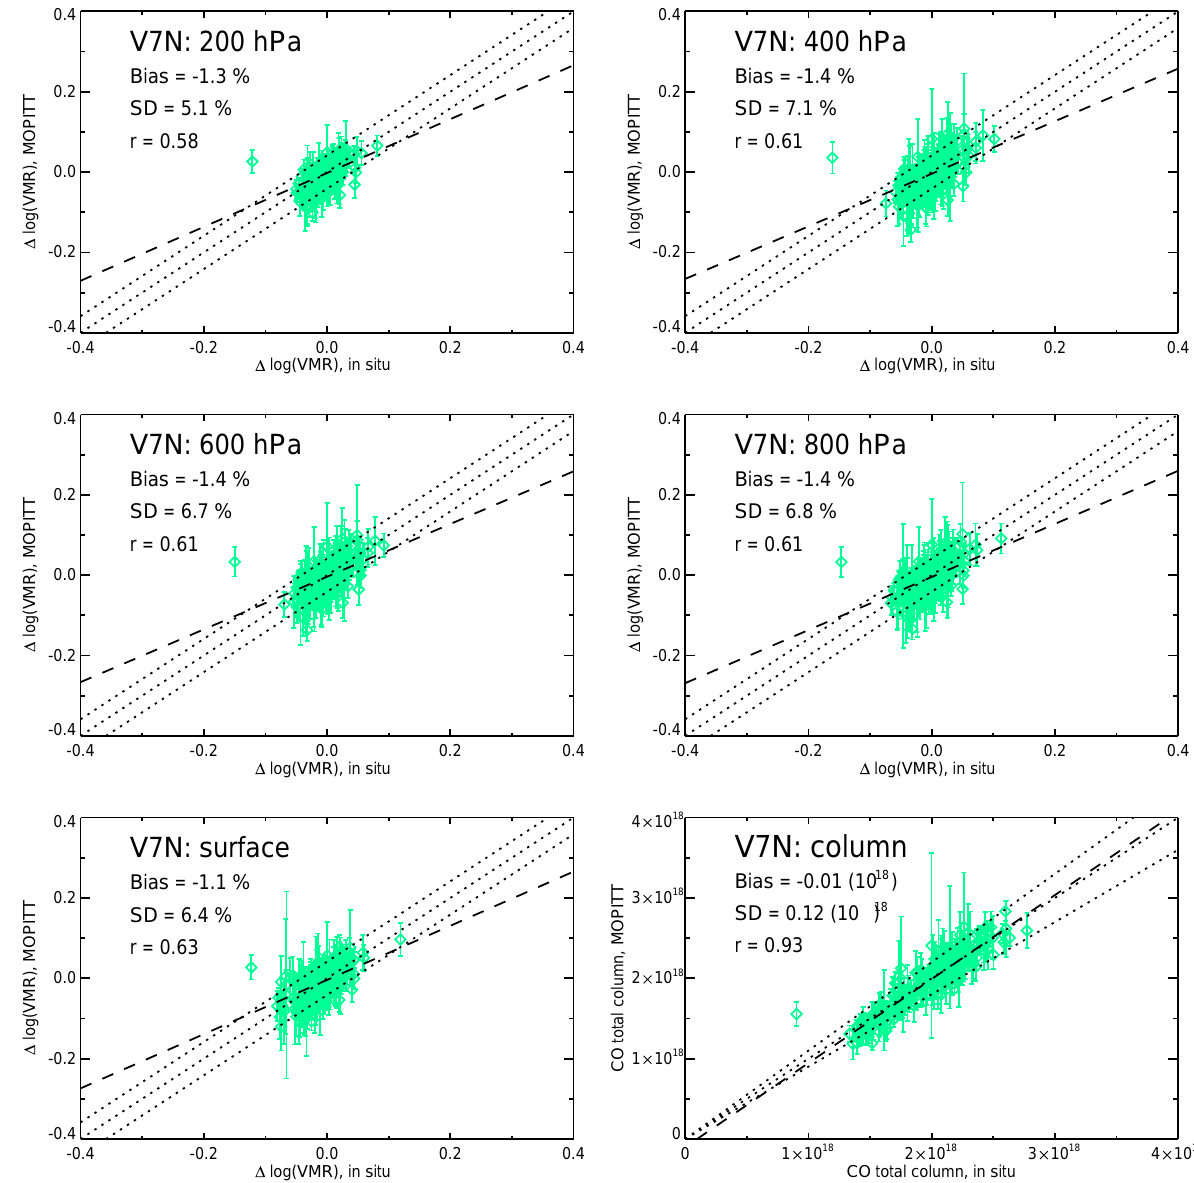
Figure 6. V7 NIR-only validation results based on the NOAA flask measurements. See caption to Fig.